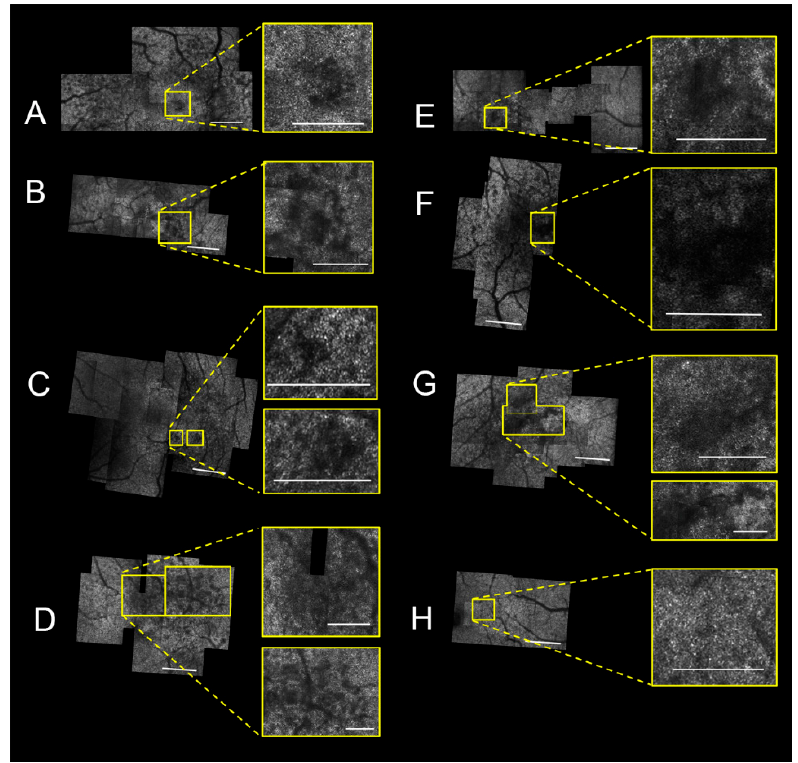
Figure 1. Adaptive optics scanning laser ophthalmoscopy (AOSLO) montage of each eye with macular telangiectasia type 2 (MacTel) reveals photoreceptor lesions. Subjects 1–8 ( A – H ). In montages A – G , 1–2 lesions were identified and magnified (inset). No lesions were identified in ( H ). Montage and inset scale bars represent 500 μ m and 250 μ m, respectively.